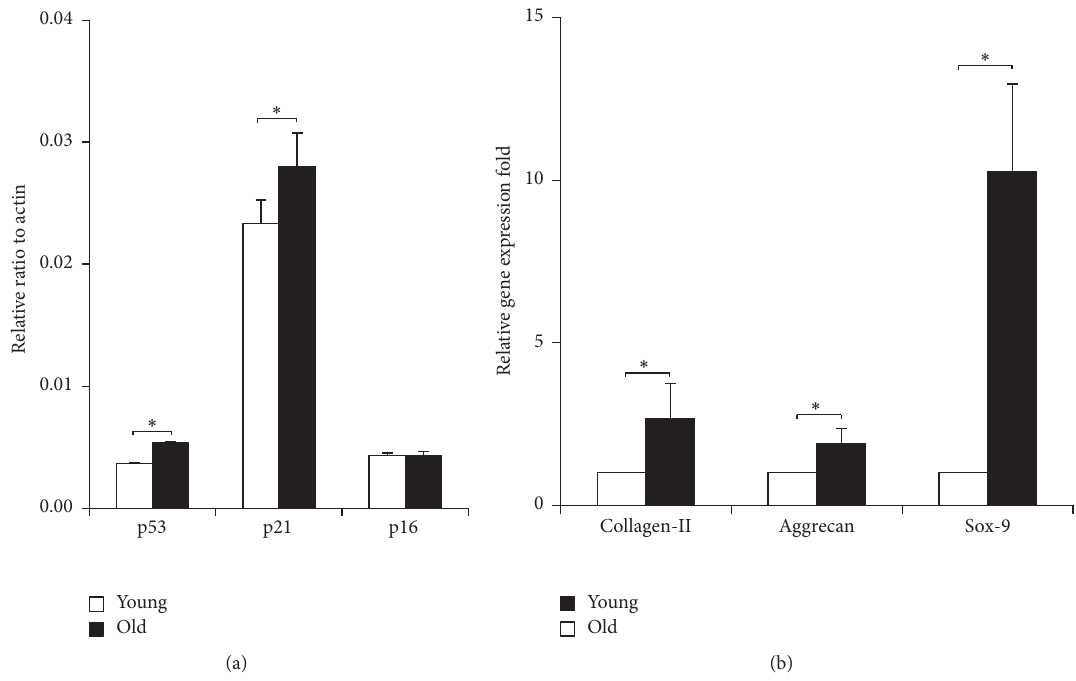
Figure 8: The mRNA expression levels of target genes in NPMSCs analyzed by real-time PCR ( 𝑛 = 5 ). (a) Increased expressions of p53, p21, and p16 were observed in old NPMSCs relative to young NPMSCs. In particular, old NPMSCs expressed significantly higher p53 and p21 than young NPMSCs. (b) Compared with old NPMSCs, young NPMSCs had significantly higher expression levels of collagen-II, aggrecan, and Sox-9. The level of mRNA expression was normalized and graphed relative to 𝛽 -actin. The data are expressed as means ± SD. ∗ indicates 𝑃 < 0.05